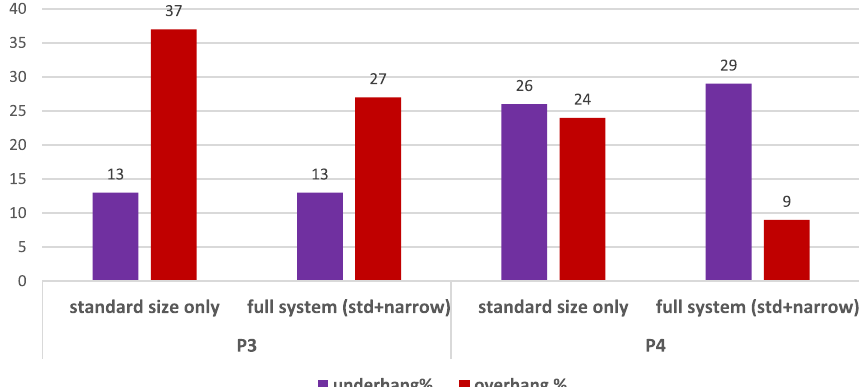
Fig. 9 Effect of adding the slim size in the evaluation of underhang and